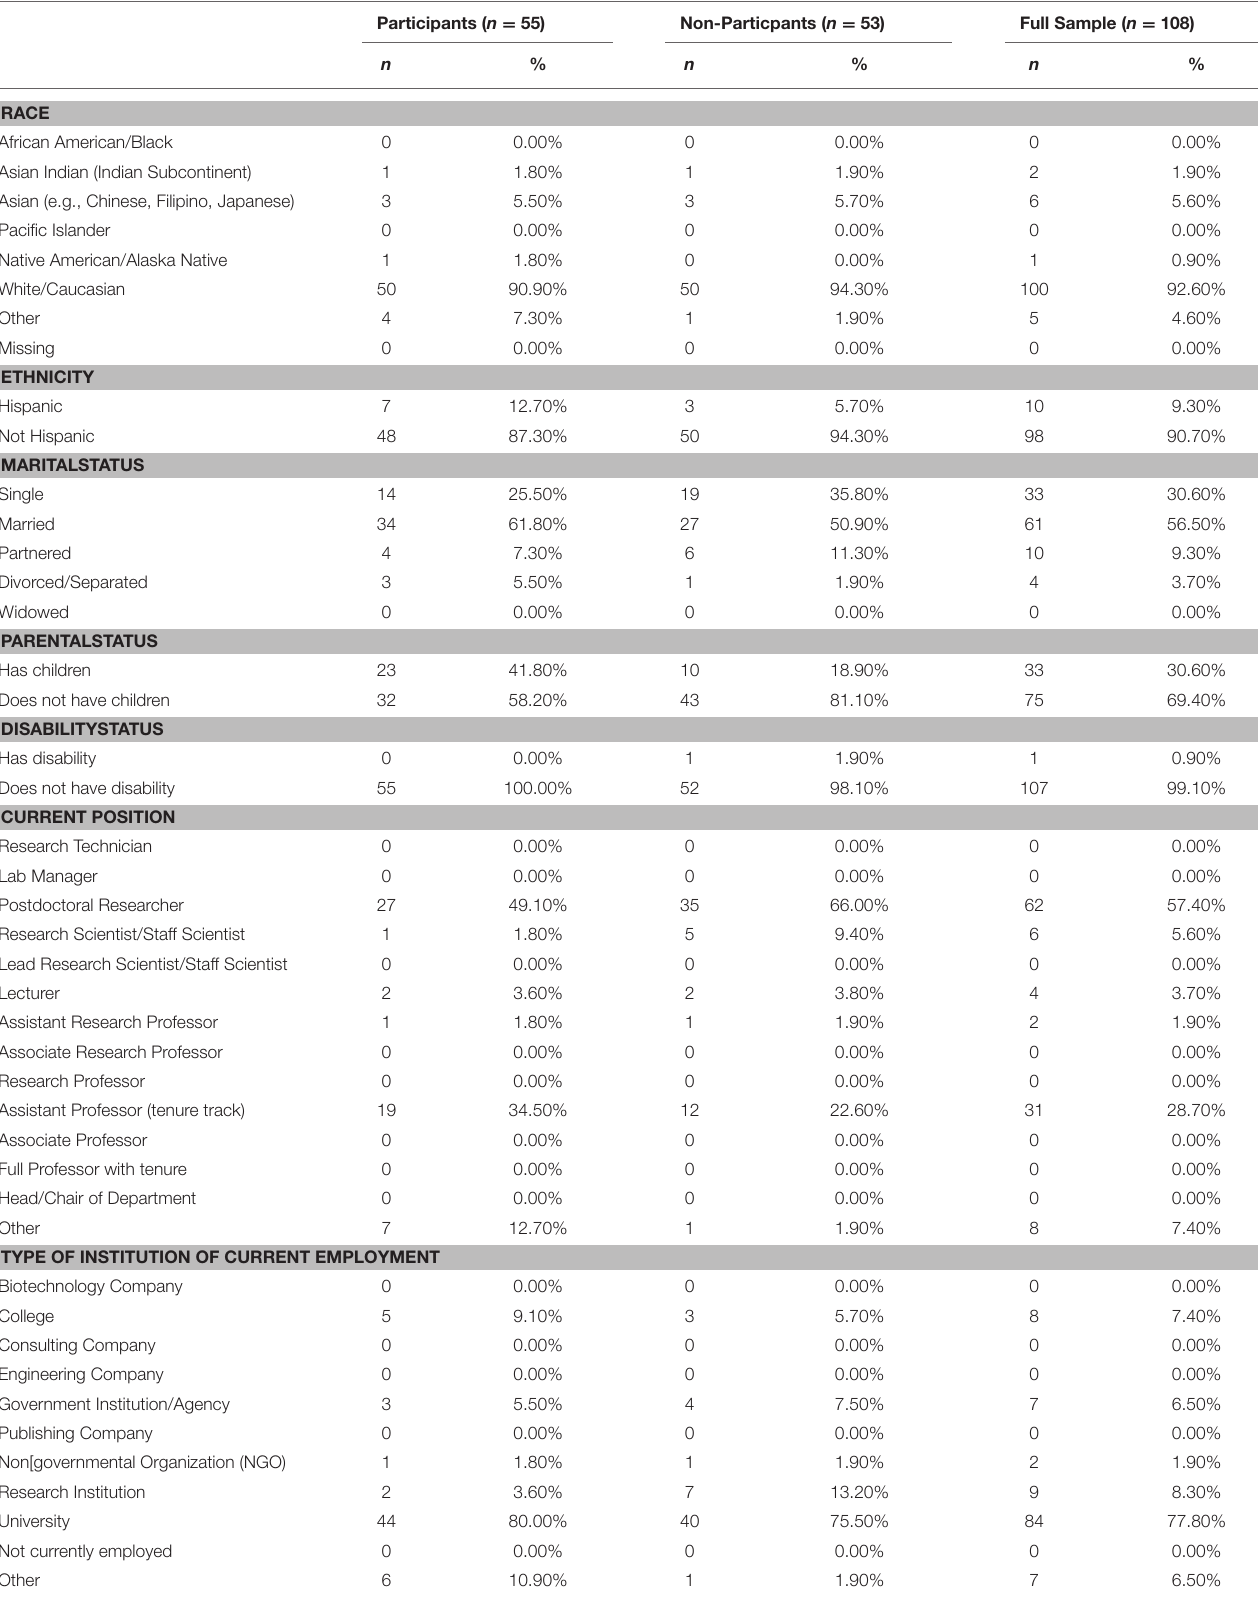
TABLE 1 | Demographics of the 2007 and 2008 combined applicant pools for WEBS. Participants ( n = 55) Non-Particpants ( n =